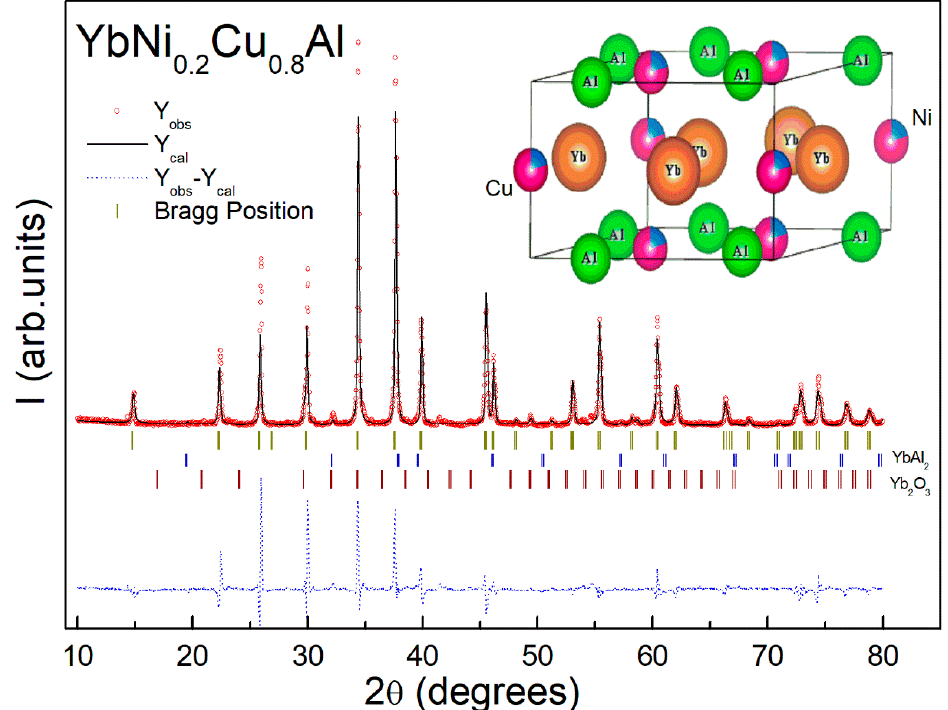
Figure 2. XRD pattern and Rietveld refinement in a representative Yb sample with x = 0.8. A good reliability of the fit is observed, with a standard Bragg factor (R B = 10.4%). Bragg positions (vertical markers) of the main phase and impurity phases (YbAl 2 and Yb 2 O 3 ) are also provided. The scheme of the typical structure (inset) with the distribution of the different atoms is shown.